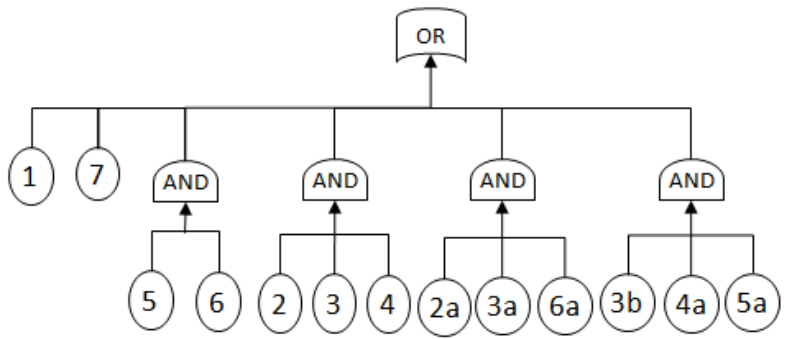
Figure 5. Equivalent Fault Tree of RBD in Figure 4. Blocks 2a-6a, 3b are duplicates of their corresponding